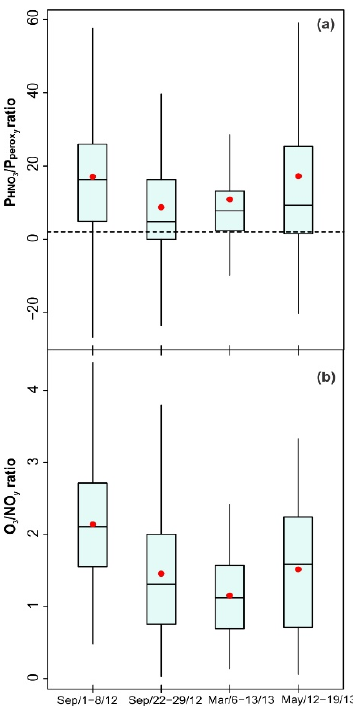
Figure 11. ( a ) P HNO 3 / P perox ratios derived from box modeling for periods of O 3 mixing ratios exceeding the 110 ppb 1 h official Mexican standard in early-fall 2012 and spring 2013. Ratios greater than two, indicated by the horizontal dotted line, are typical of VOC-sensitive regimes; ( b ) O 3 /NO y ratios derived from observations made at the OBI site during the same periods. O 3 /NO y ratios lower than six are typically observed in VOC-sensitive regimes.